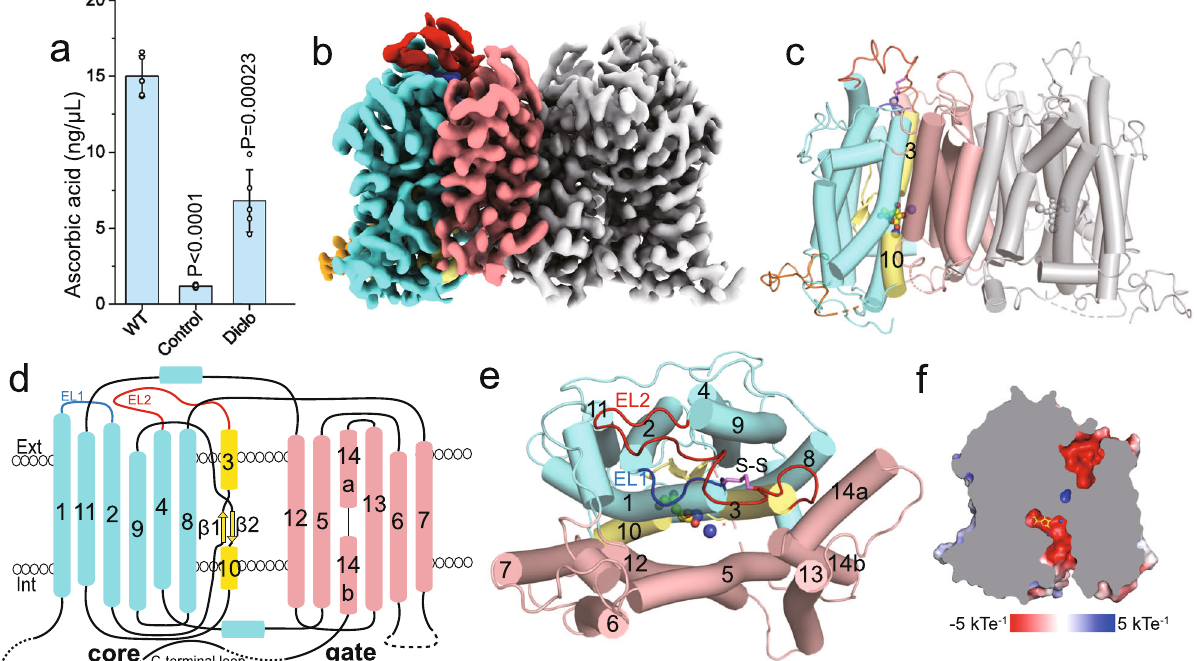
Fig. 1 | Overall structure of MmSVCT1. a Ascorbic acid uptake activities of MmSVCT1.WT,wild-type;Diclo,diclofenamicacid.Datapointsarethemean±SEM ( n =5 independent experiments). P values from the two-tailed t -test are indicated on the bar chart. Source data are provided as a Source Data fi le. b , c Cryo-EM density map ( b ) and cartoon representation ( c ) of the MmSVCT1 dimer with one subunit colored by individual elements and the other colored gray. Vitamin C is